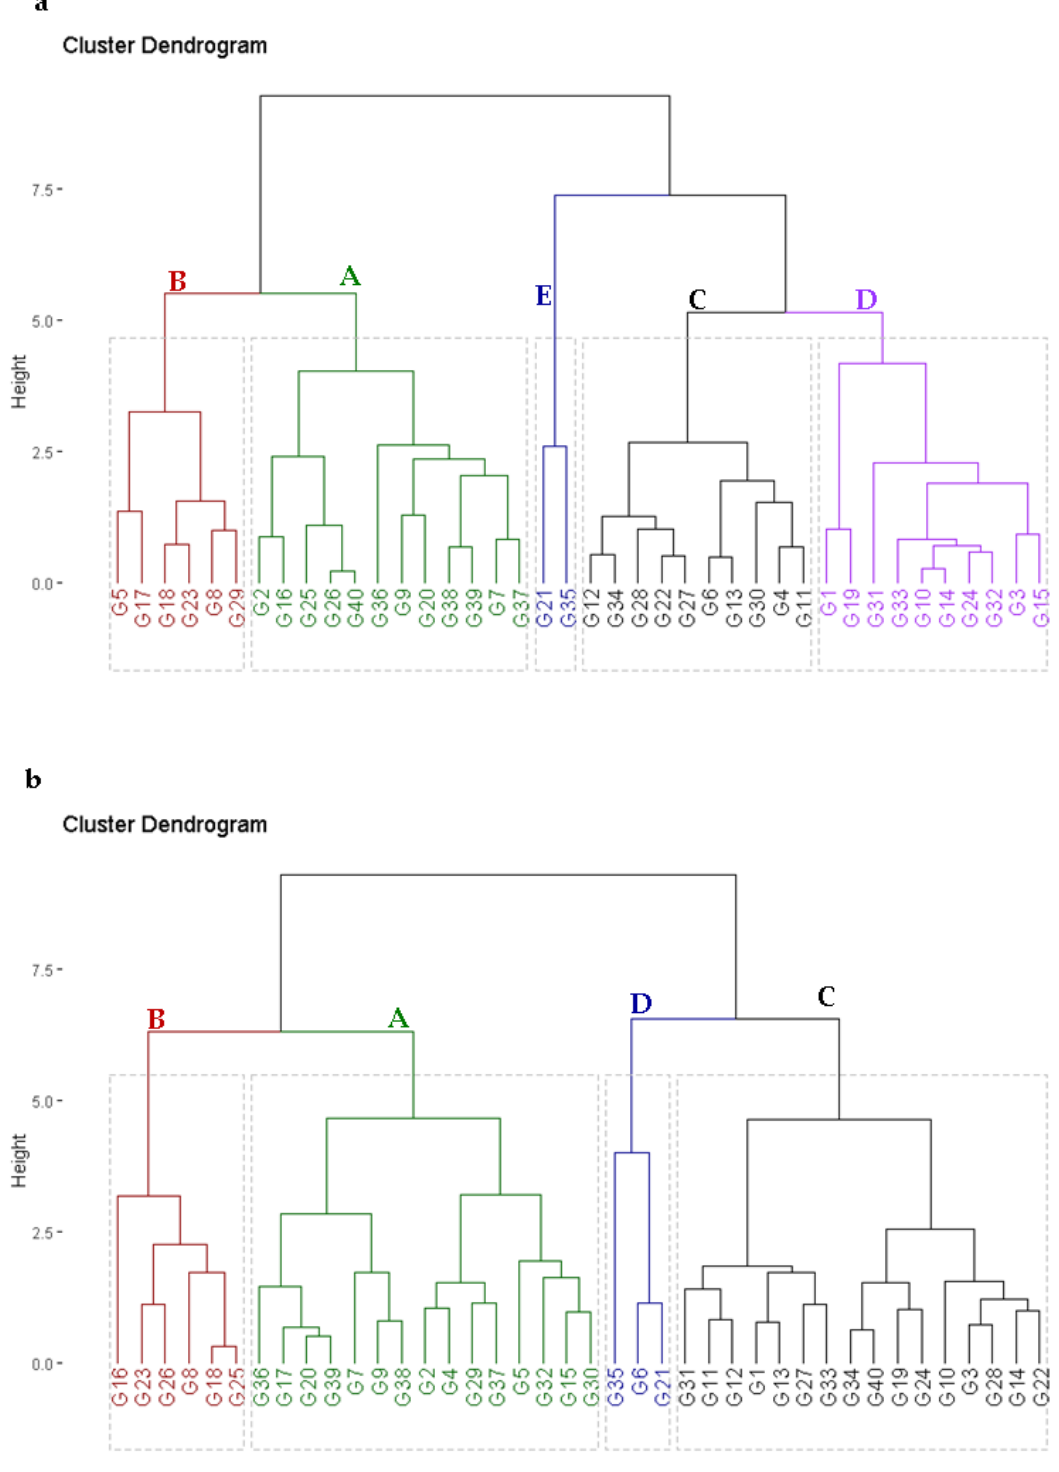
Figure 1. Dendrogram of the phenotypic distances among 40 maize hybrids based on their agronomic performance under high planting density at timely sowing ( a ) and late sowing ( b ) .